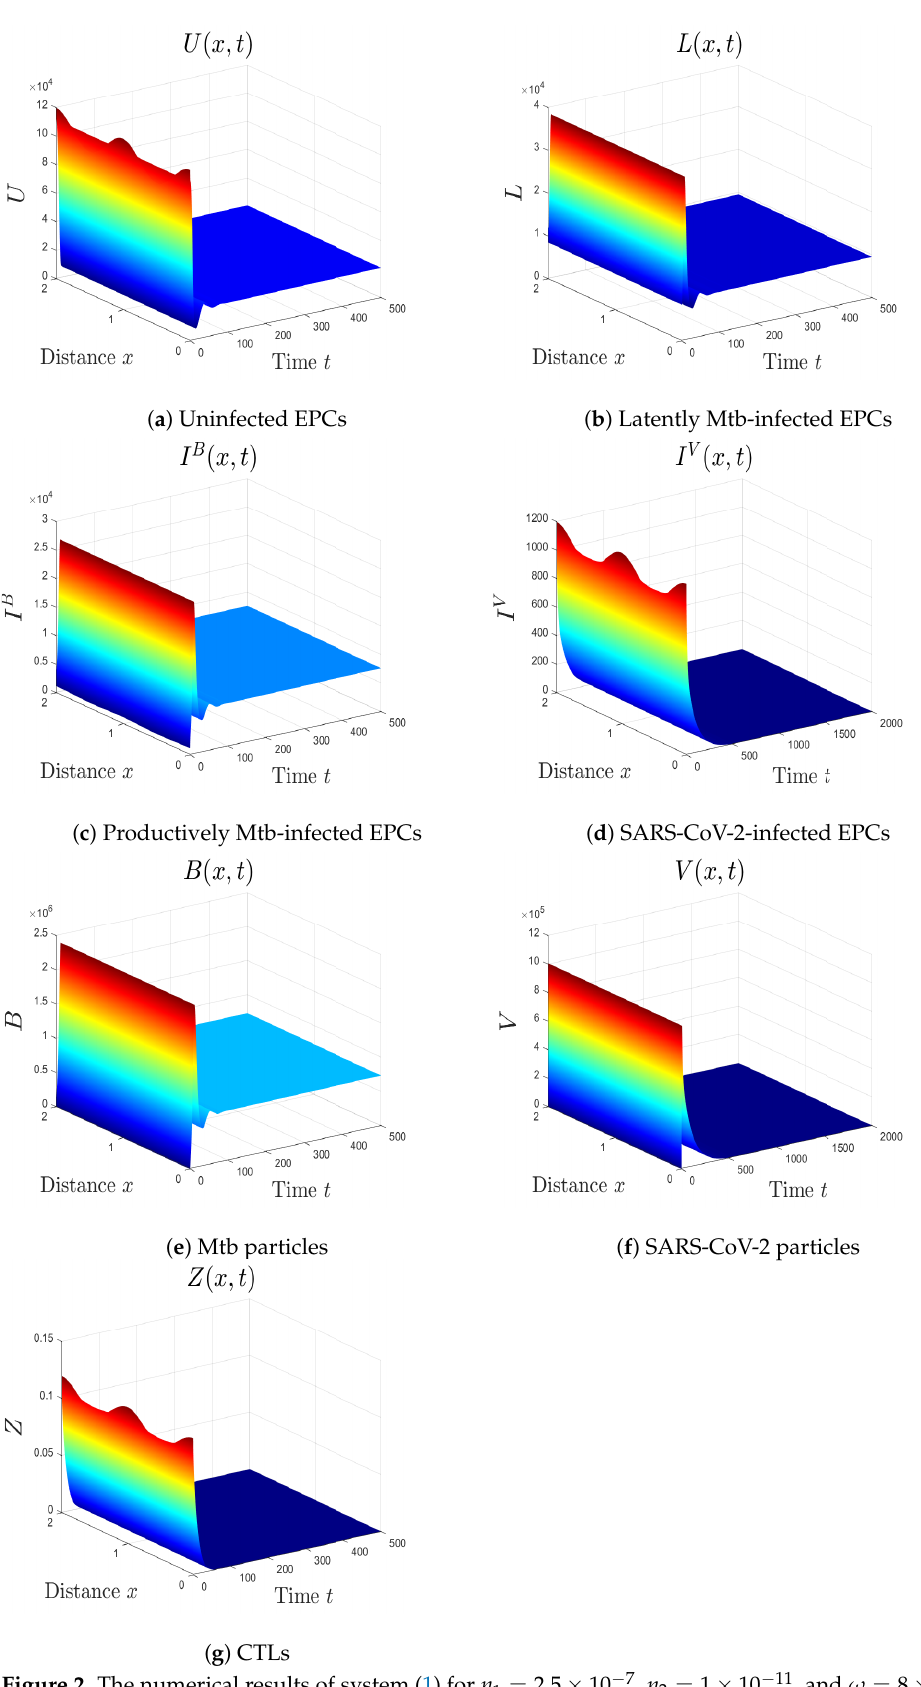
Figure 2. The numerical results of system (1) for η 1 = 2.5 × 10 − 7 , η 2 = 1 × 10 − 11 , and ω = 8 × 10 − 7 . The equilibrium E 1 = ( 20,800,9480,7584,0,729,231,0,0 ) is